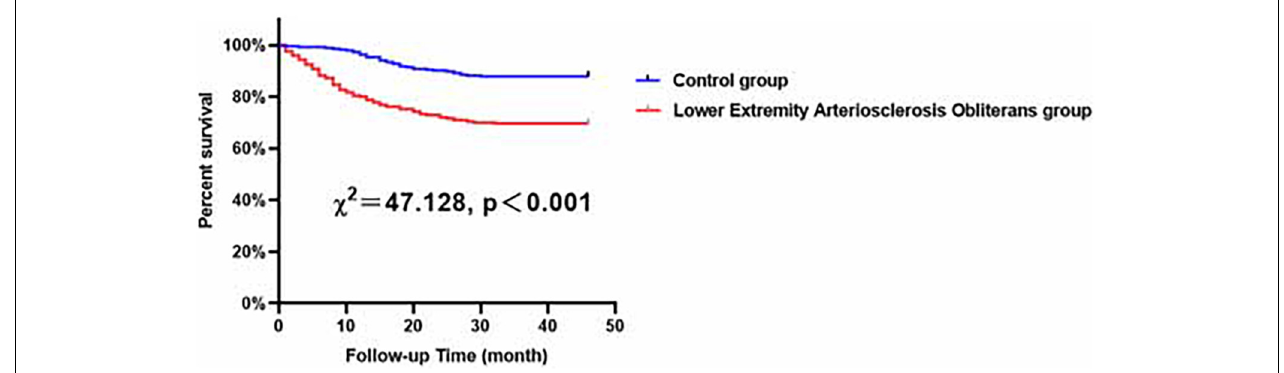
FIGURE 1 | Major adverse cardiovascular and cerebrovascular events (MACCEs)-free survival rates for patients with LEASO group and control group during the follow-up period.